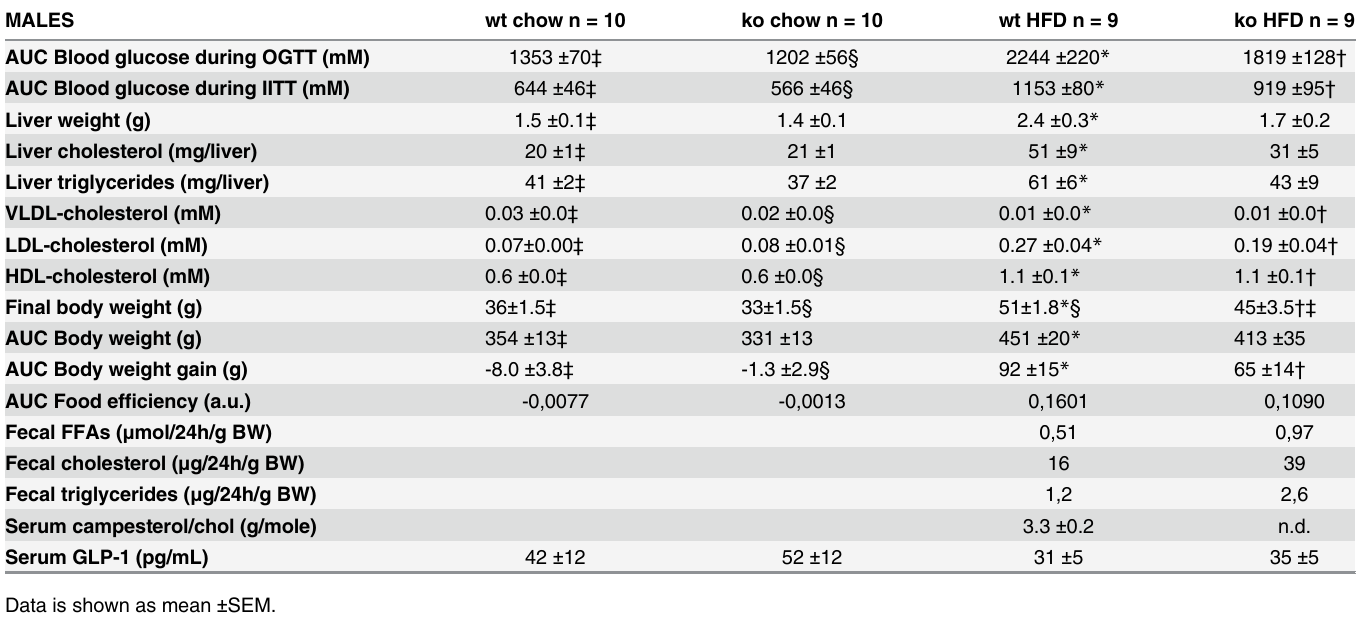
Table 2. Responses to a high fat diet (HFD) in male Cyp8b1-/- mice (ko) and their wildtype (wt) littermates.